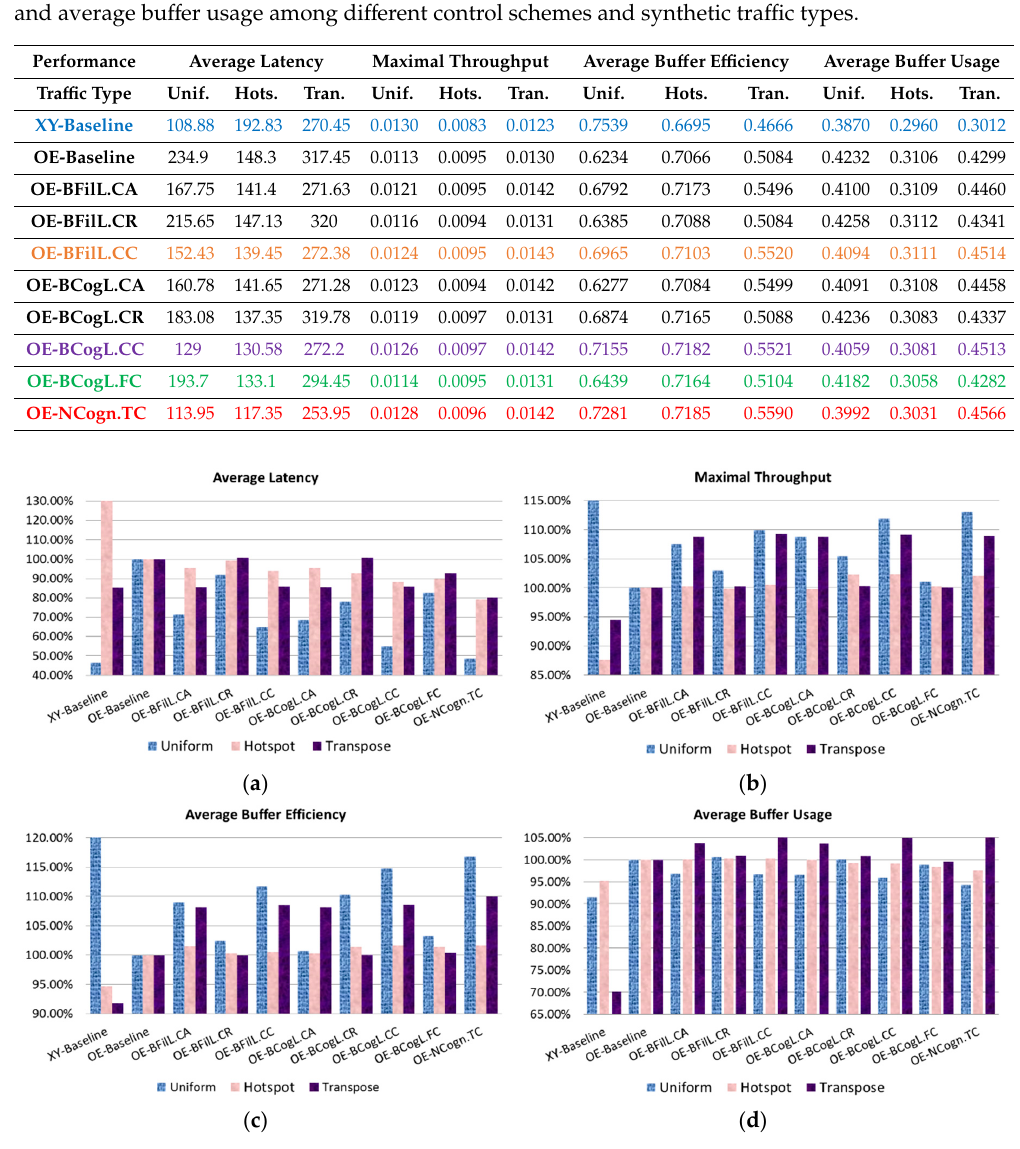
Figure 15. Comparisons in ( a ) average latency, ( b ) maximal throughput, ( c ) average buffer efficiency, and ( d ) average buffer usage among different traffic control schemes and synthetic traffic types.